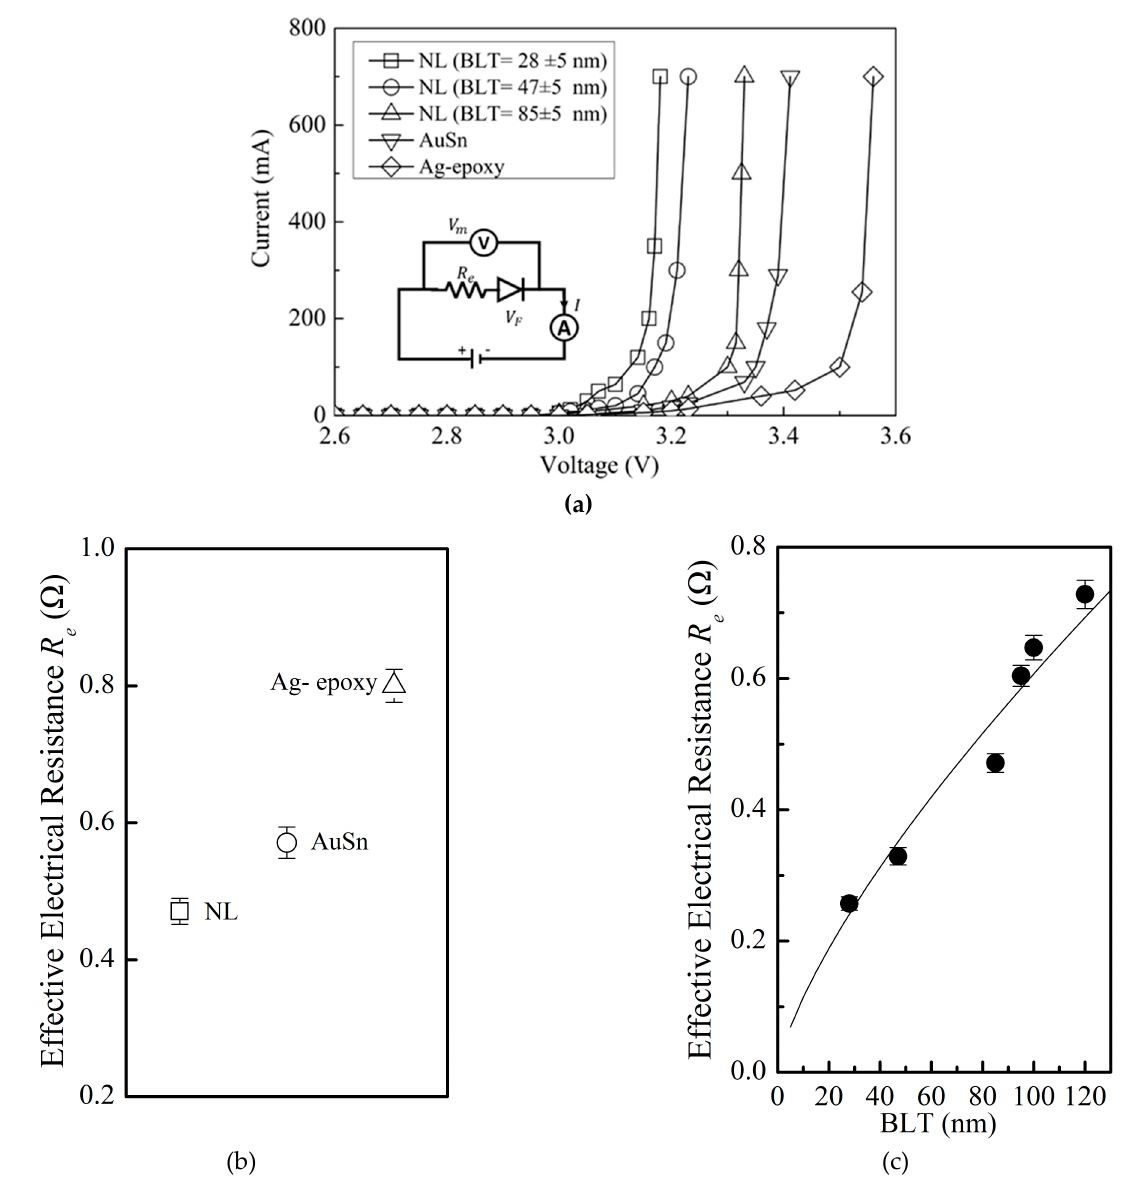
Figure 4. ( a ) Measurement of current (I) and voltage (V) relationship for the devices made of the present NL and conventional die–substrate interconnection and bonding methods. The open square symbol ( □ ) represents the NL bonding with BLT = 28 ± 5 nm, the open circle symbol ( ○ ) represents the NL bonding with BLT = 47 ± 5 nm, the open triangle symbol ( Δ ) represents the NL bonding with BLT = 85 ± 5 nm, the open triangle symbol ( ∇ ) represents the AuSn bonding; the open rhombus symbol ( ◊ ) represents the Ag-epoxy bonding. The solid curve represents the best I-V fitting. ( b ) The 𝑅 (cid:3032) of different die–substrate bonding and connection methods: the open square symbol ( □ ) represents NL bonding with BLT = 85 ± 5 nm, the open circle symbol ( ○ ) represents AuSn bonding, the open triangle symbol ( Δ ) represents Ag-epoxy bonding. ( c ) The solid circle symbol ( ● ) correspond to the extracted values for 𝑅 (cid:3032) in the NL approach, which indicates 𝑅 (cid:3032) decreases with decreasing BLT which can be described by 𝑅 (cid:3032) = 0.0215 (BLT) 0.7254 (the solid curve).